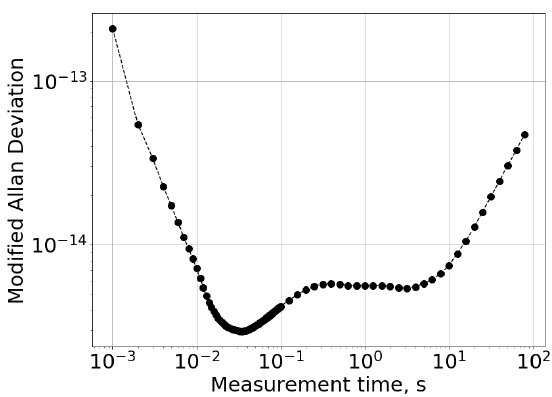
Fig. 1. Fractional frequency instability of laser stabilized to silicon cavity obtained by comparison of two identical